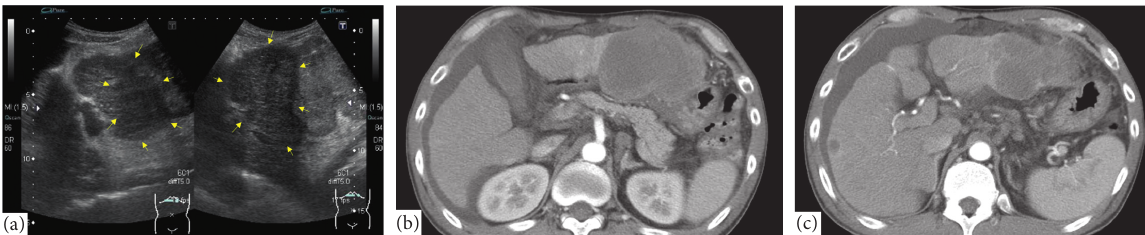
Figure 1: (a) Abdominal ultrasound showing a hypoechoic, mosaic-like, giant mass in the lateral segment of the left hepatic lobe of the cirrhotic liver (arrows). (b), (c) Early arterial phase of a contrast-enhanced computed tomography scan showing an 8cm hypodense mass in the left hepatic lobe, a hypodense mass with ring-like enhancement in the right lobe, and multiple swollen lymph